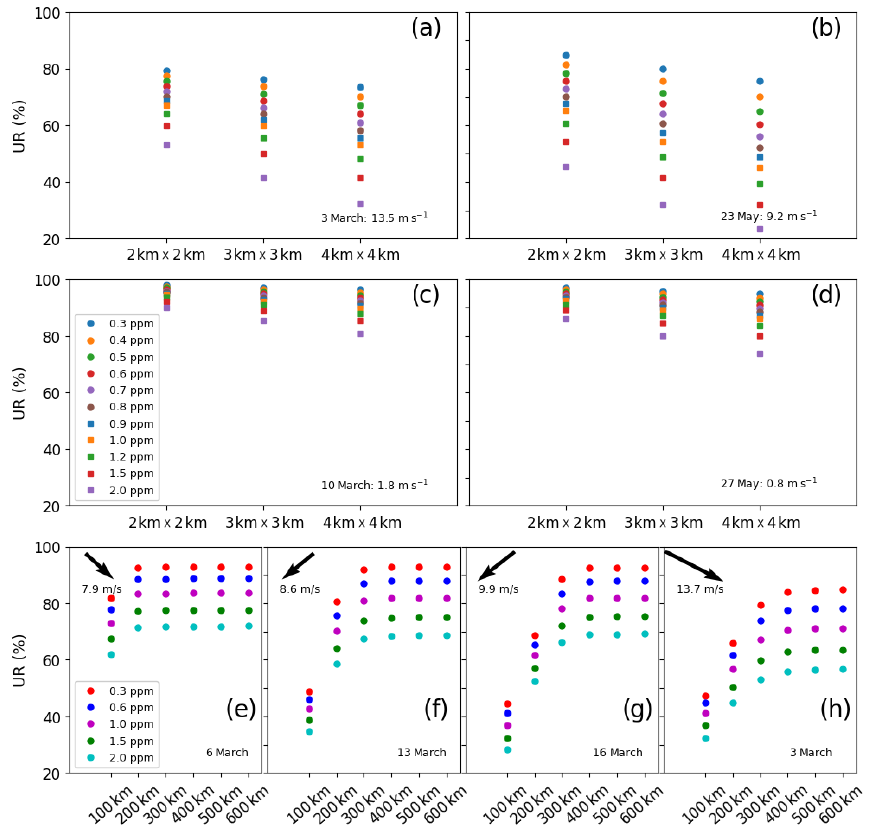
Figure 4. Uncertainty reductions (UR) from a 50% prior uncertainty for the 6h budgets of the Paris emissions. In panels (a) – (d) , results are displayed for 4 different days characterized by different wind speeds, for different spatial resolutions of the satellite data ( x axis) and for different precisions (colored markers). In panels (a) – (d) , results are generated by considering a swath of 300km. In panels (e) – (h) , results are displayed for 4 different days characterized by different wind speeds, for different swaths of the satellite data ( x axis), for different precisions (colored markers) and for a resolution of 2km by